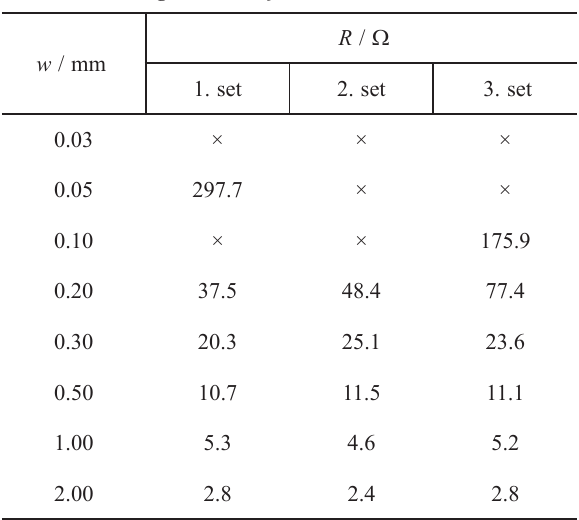
Table 1 – Resistances of three sets of printed PMA-AgNP lines with varying widths (w), measured after sin- tering at 105 °C for 30 min R / w / mm